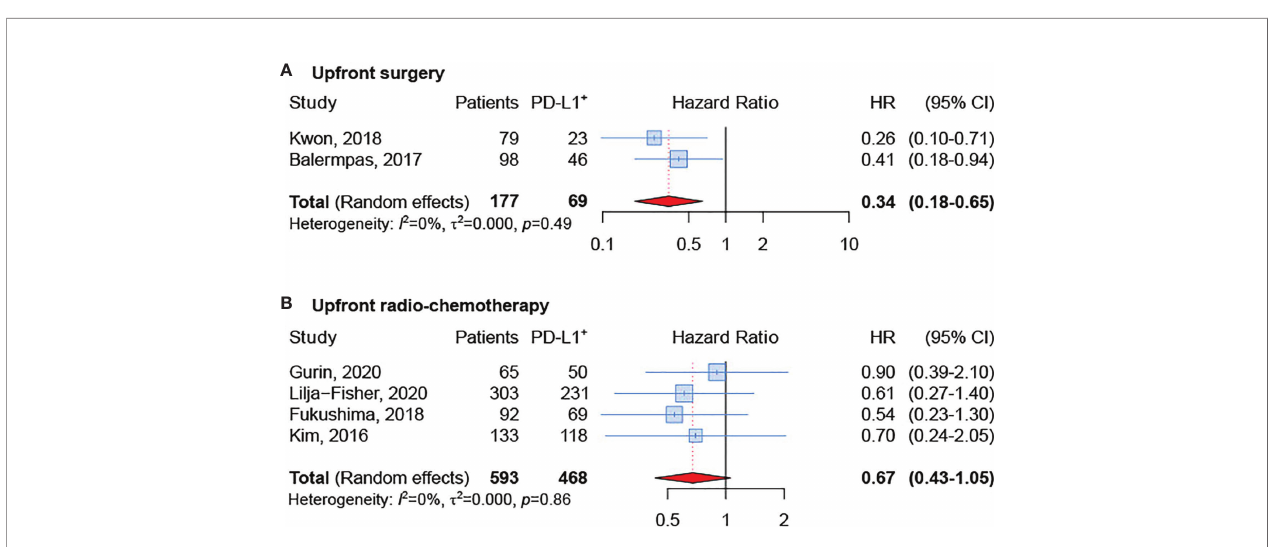
FIGURE 4 | Forest plot for the association between PD-L1 expression and overall survival in patients undergoing upfront surgery (A) or upfront radio-chemotherapy (B)